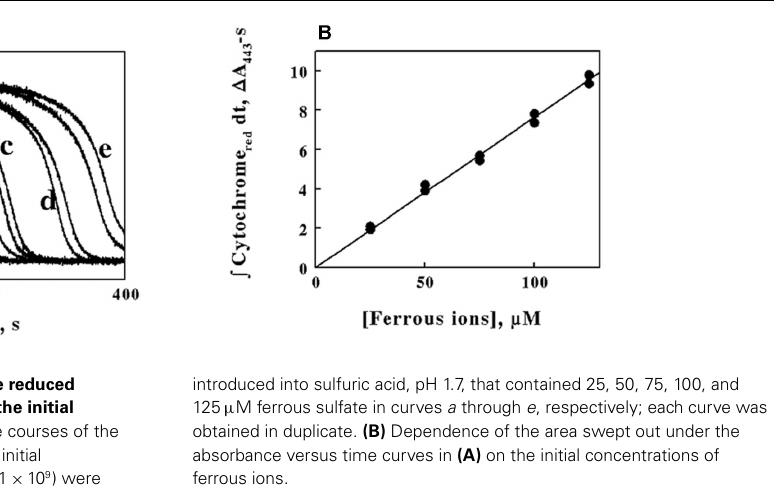
introduced into sulfuric acid, pH 1.7, that contained 25, 50, 75, 100, and 125 μ M ferrous sulfate in curves a through e , respectively; each curve was obtained in duplicate. (B) Dependence of the area swept out under the absorbance versus time curves in (A) on the initial concentrations of ferrous